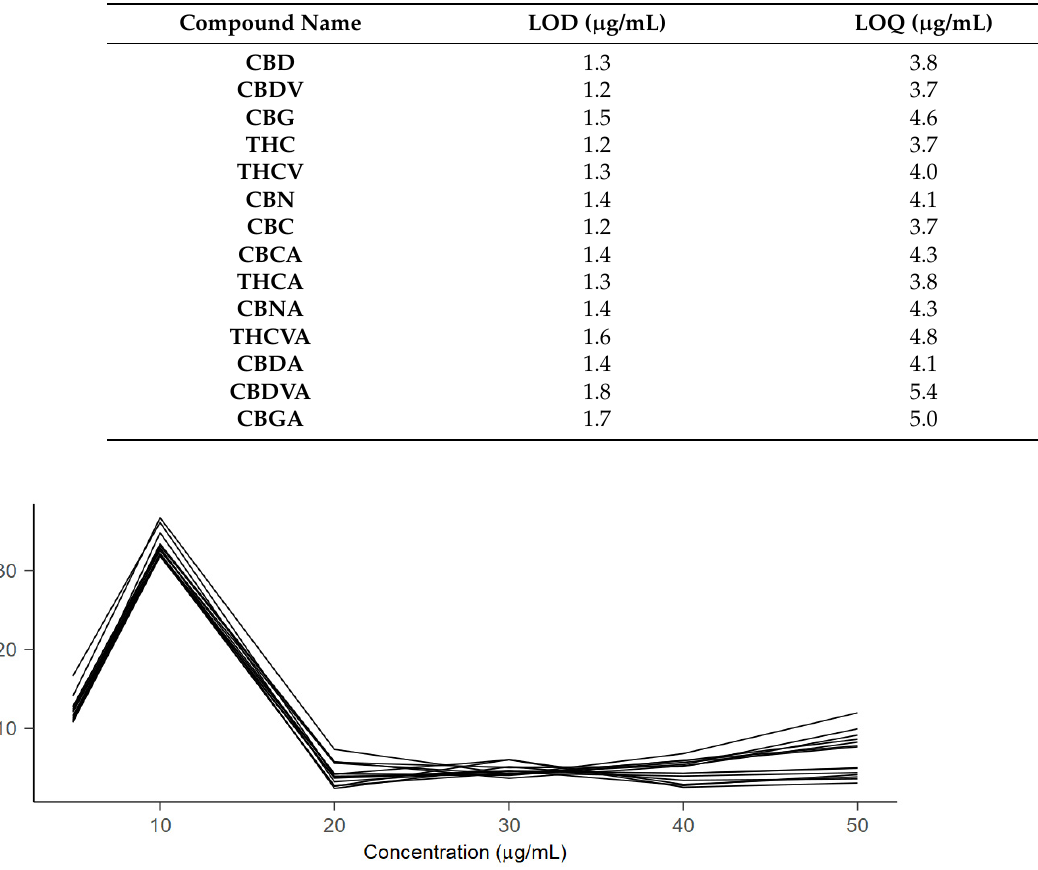
Figure 4. Relative standard deviations (RSD) for the peak areas (precision) for each cannabinoid at different concentrations ( n = 3). Peak areas were normalized to migration times. Table 1. Limits of detection (LOD) and quantification (LOQ) for cannabinoid compounds ( n = 7).